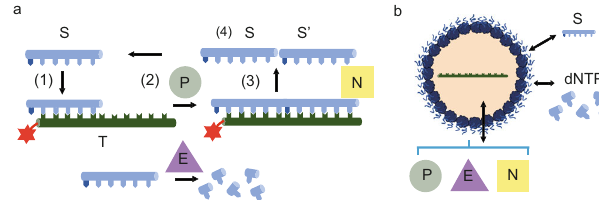
Fig. 1 Design for compartmentalised PEN DNA reactions in proteinosomes. a General description of PEN DNA reaction, (1) S binds to its complementary template T; (2) polymerisation by polymerase (P) of S along T, followed by nicking with nickase (N) to produce S and S ′ ; (3) dissociation of S and S ′ from the template T. (4) Degradation of S and S ′ by exonuclease inside and outside the proteinosome maintains an out-of- equilibrium state for the system. b Cartoon of compartmentalised PEN DNA reactions. Template DNA (T) is encapsulated within the proteinosome. Substrate DNA (S); dNTPs; polymerase, exonuclease and nickase enzymes are loaded outside of the proteinosome and diffuse into the proteinosomes to initiate the